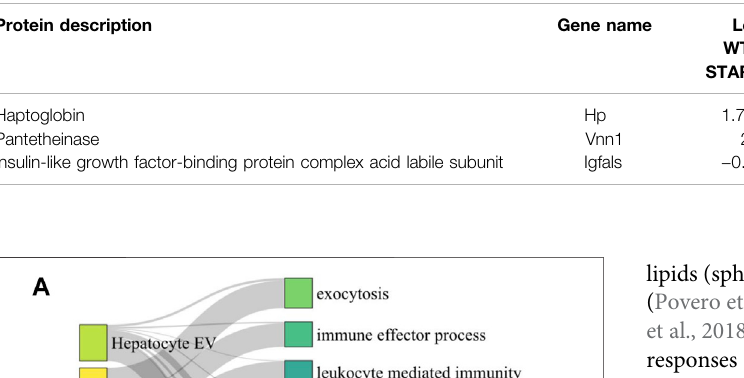
TABLE 5 | Palmitate-stimulated EV proteins also detected in plasma.